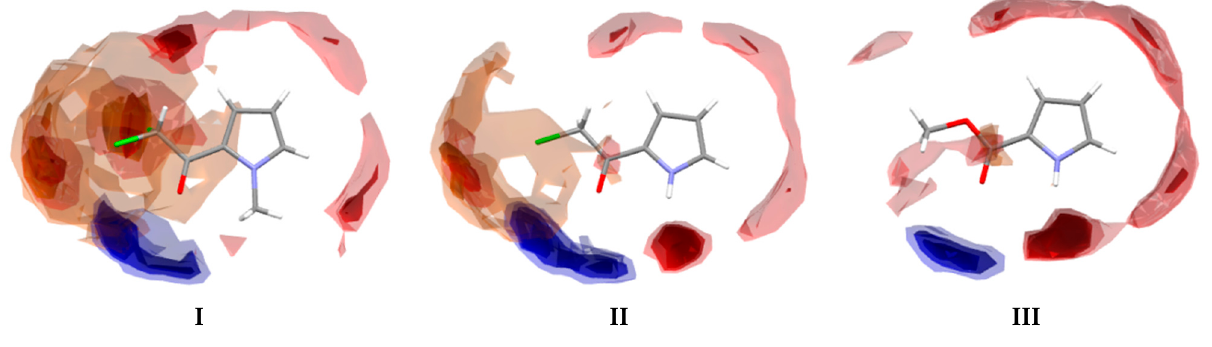
Figure 3. Full interactions maps for investigated compounds I – III .